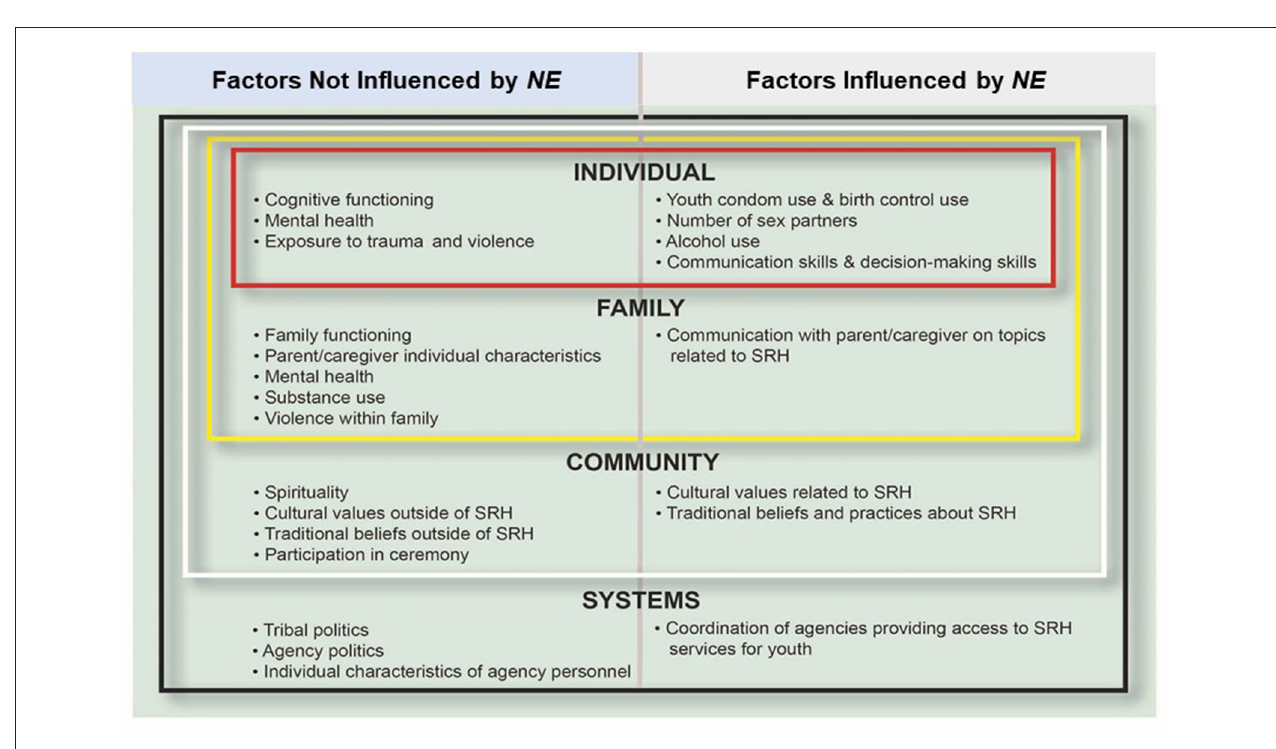
FIGURE 3 | NE ’s conceptual